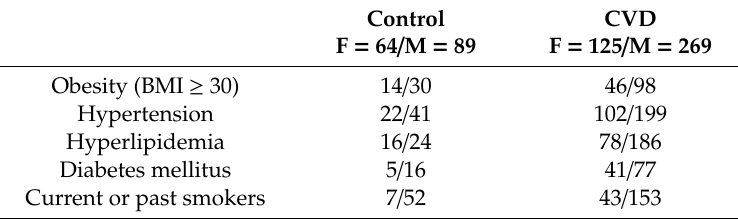
Table 1. Characteristics of the Study